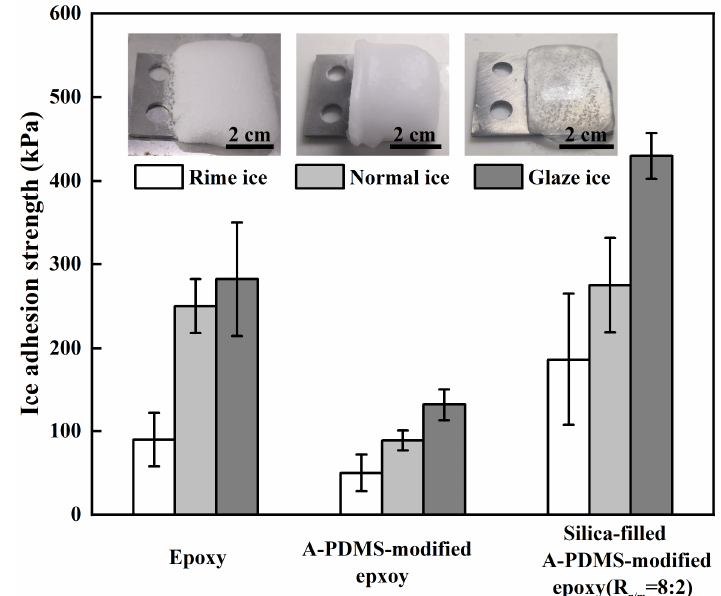
Figure 12. Ice adhesion strength of epoxy, A-PDMS-modified epoxy and nano/microsilica-filled A-PDMS-modified epoxy for three ice types (rime ice, normal ice and glaze ice) at −10 °C. The insets are photographs of rime ice, normal ice and glaze ice. The scale bar is approximately 2 cm, and the error bar is one standard deviation.